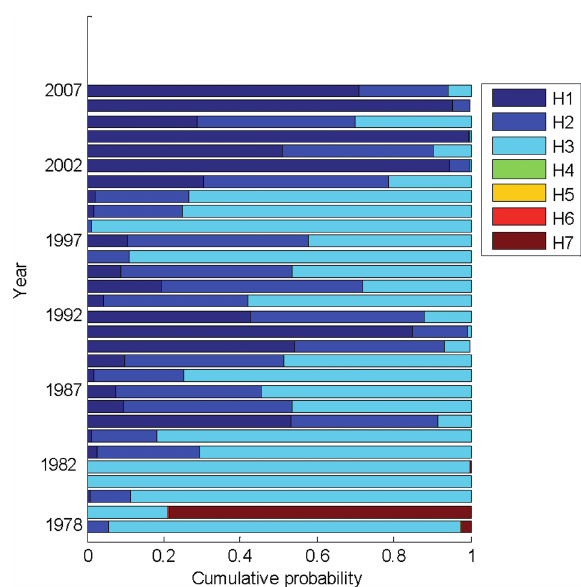
Fig . 5. – Fishery status shown as the probability of the fishery being located in each region in the TLCR for each study year, 1978 to 2007. The 2007 bar corresponds to Figure 2b.